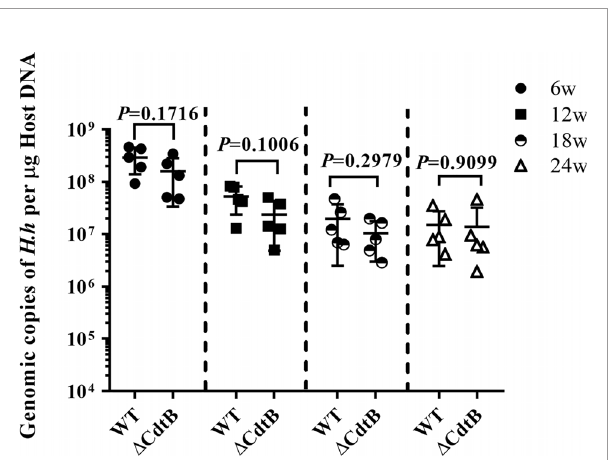
FIGURE 1 | The absence of CdtB did not affect the colonic colonization of H. hepaticus in mice. The levels of H. hepaticus in the respective samples were expressed as its genomic copies per m g of mouse colon DNA. Data are expressed as the means ± SEM (n = 5/group). Statistics were analyzed using unpaired two-tailed Student ’ s t